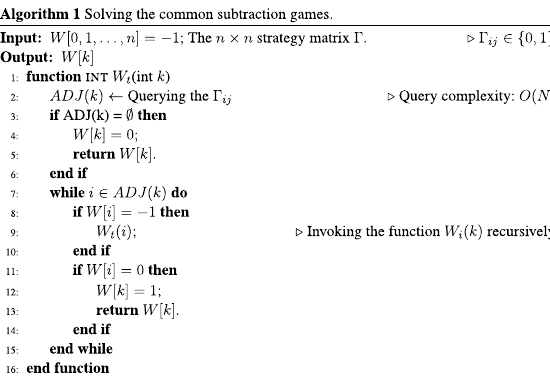
Algorithm 1. Solving the common subtraction